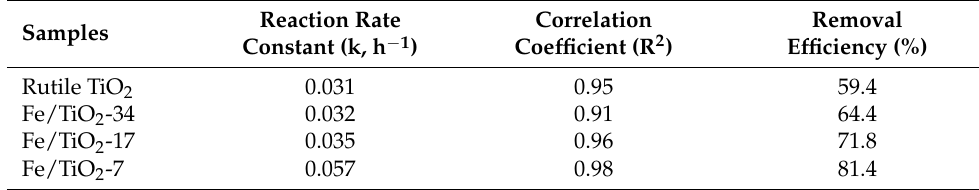
Table 2. Kinetic parameters of the Fe/TiO 2 samples ( C 0 = 0.025 mM, catalyst = 1 g/L).